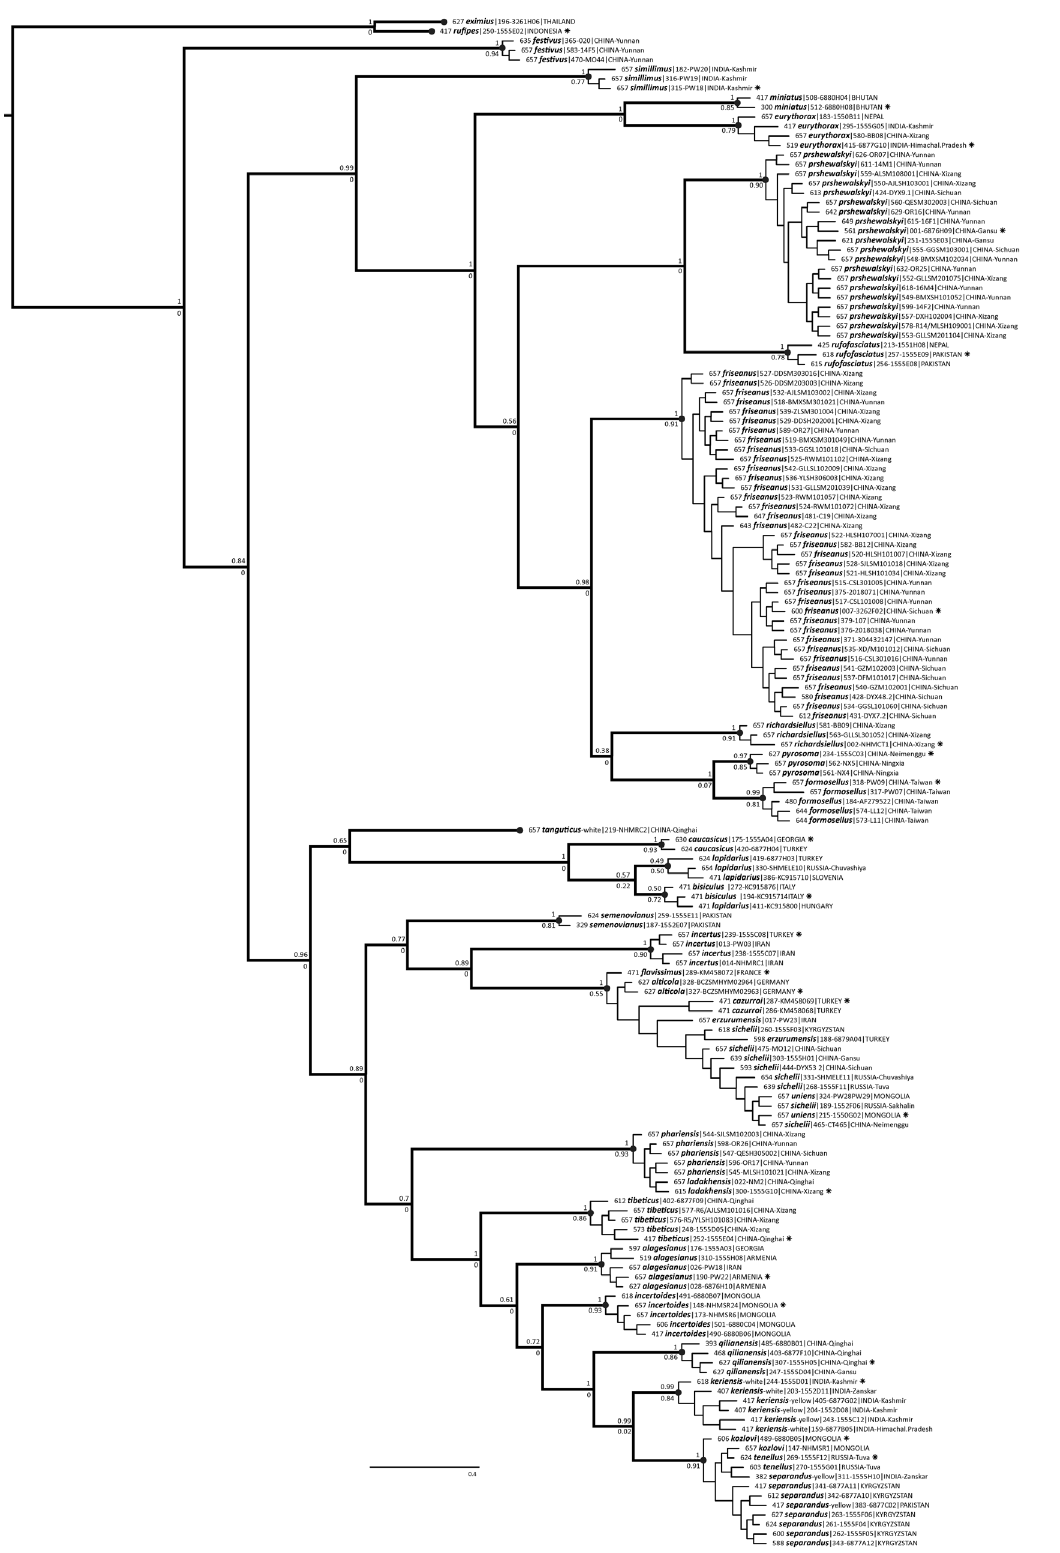
Fig. 10. October 2019 (Fig. 8) Bayesian PTP analysis of MrBayes tree of unique COI barcodes (UHF- PTP). Symbols as in Fig.